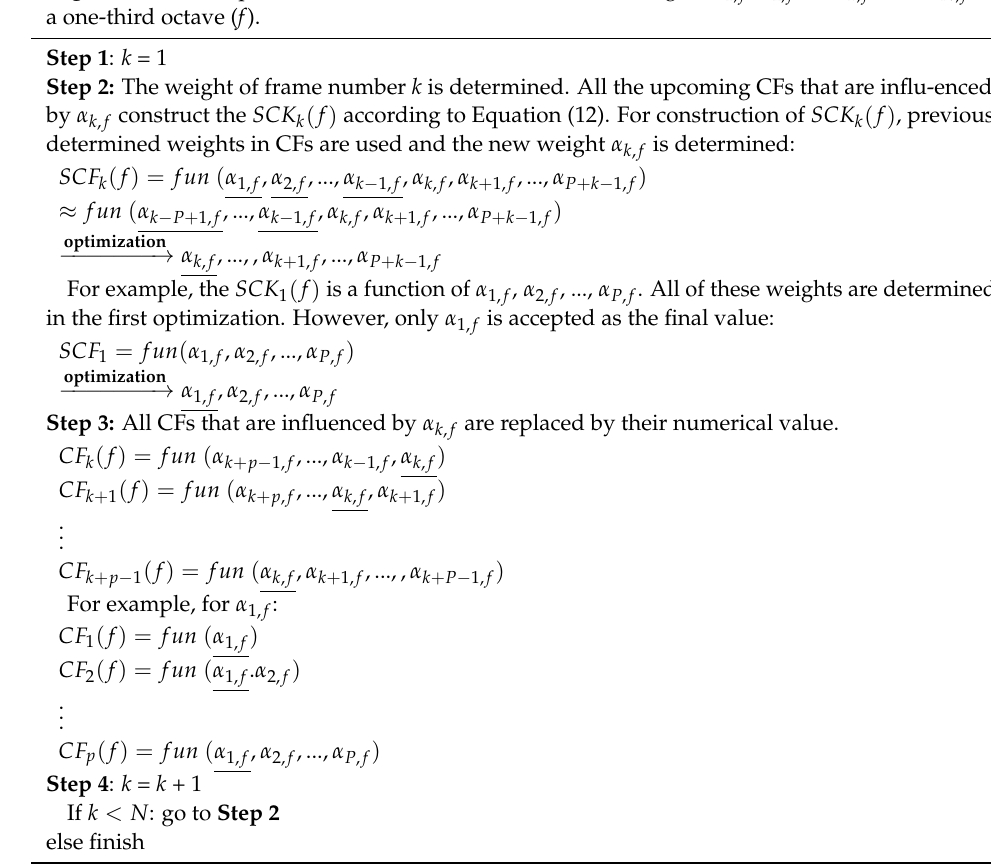
Algorithm 1. Example text of a theorem. Determination of weights α 1, f , α 2, f , ..., α k , f , . . . , α N , f